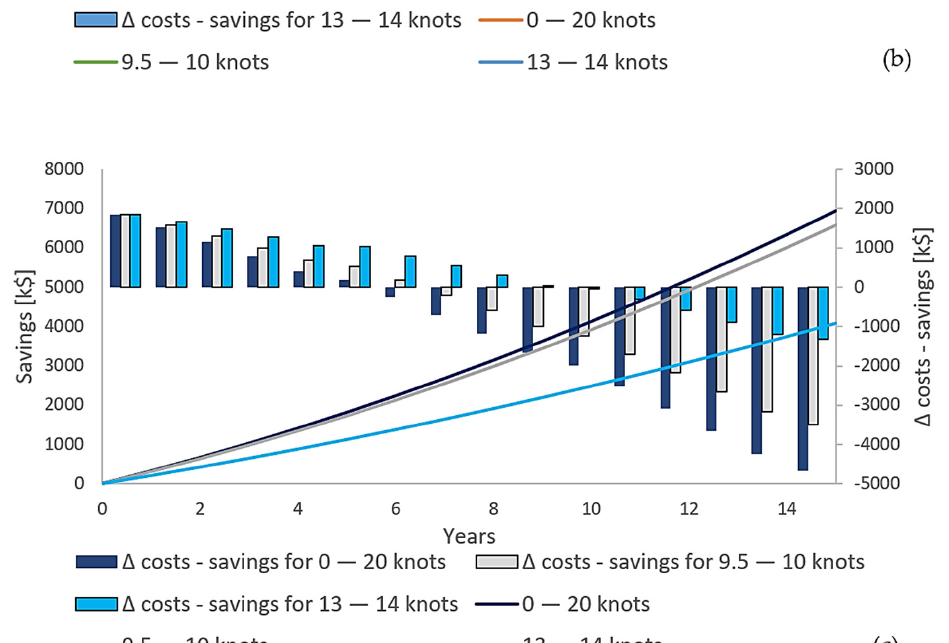
Figure 19. 6DOF simulation for a route from New York to Lagos in different rotor configurations: ( a ) D = 5 m and AR = 6; ( b ) D = 3 m and AR = 8; ( c ) D = 3 m and AR = 6.